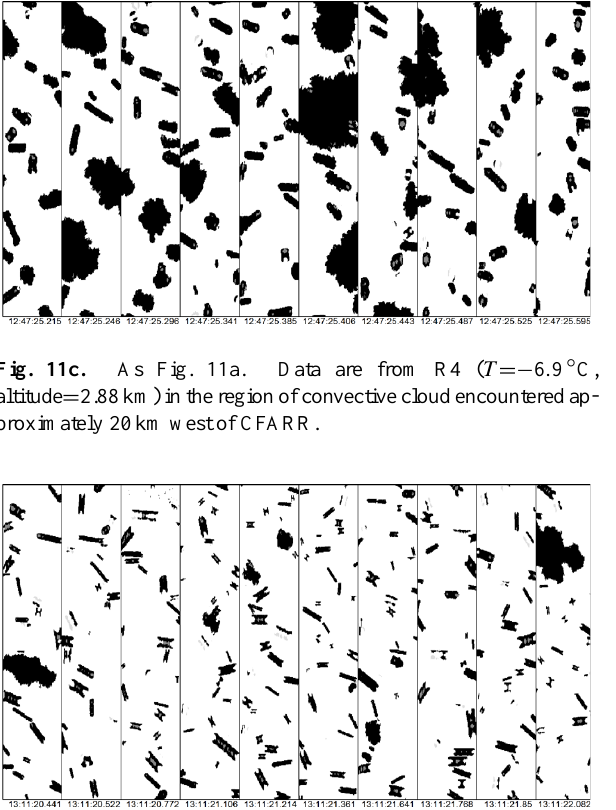
Fig. 11b. As Fig. 11a. Data are from R3 ( T =− 9 . 3 ◦ C, altitude = 3.18km) in the region of convective cloud encountered ap- proximately 20km west of CFARR.